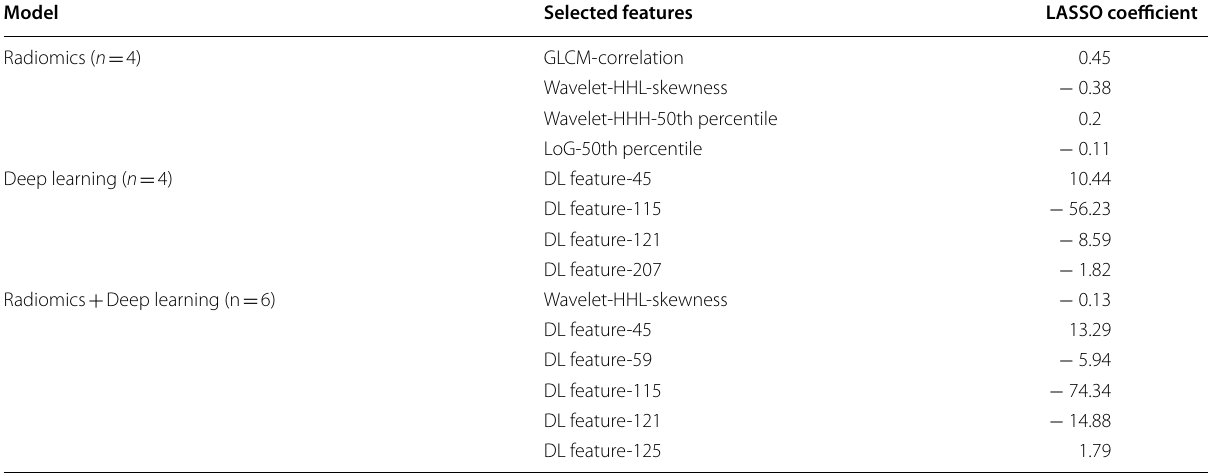
GLCM Gray-level co-occurrence matrix, LoG Laplacian of Gaussian, DL Deep learning